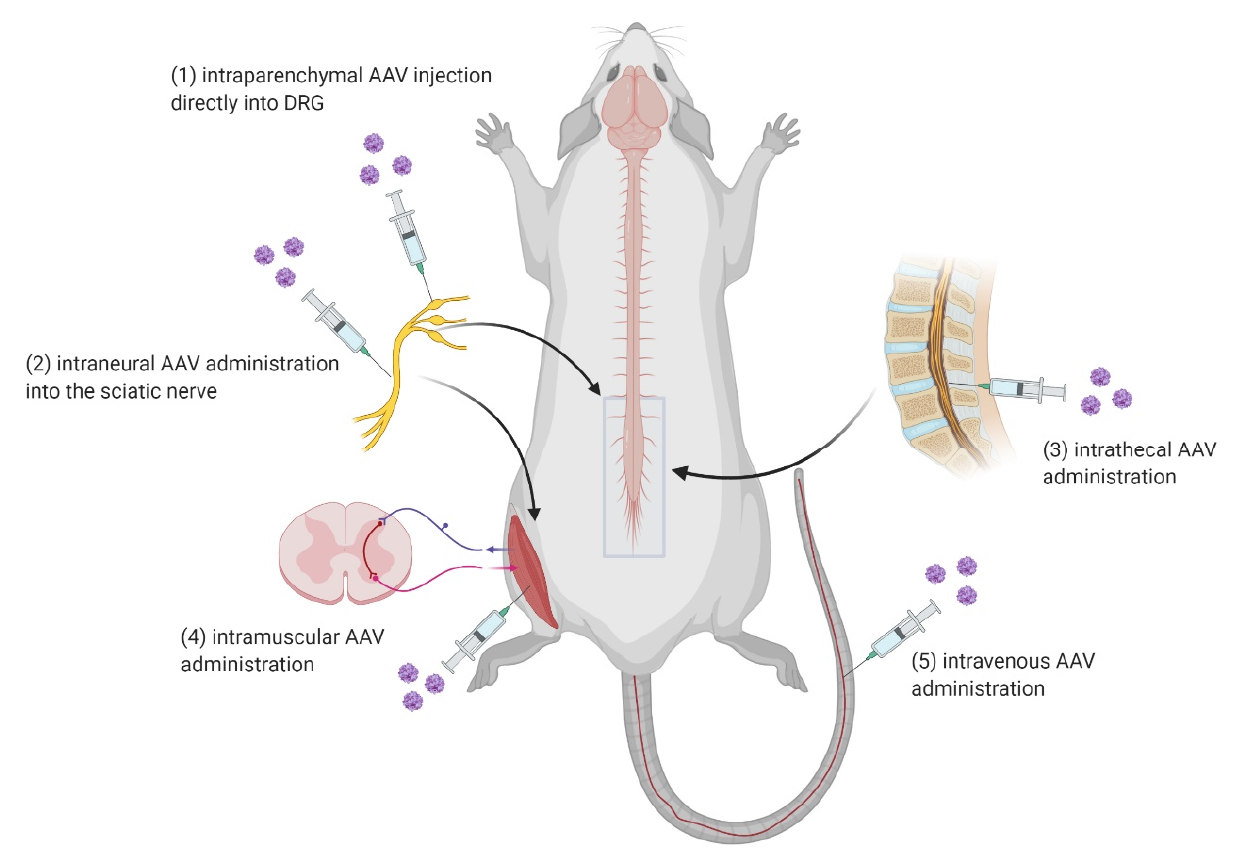
Figure 3. Possible routes of AAV vector administration into the spinal cord: ( 1 ) intraparenchymal, ( 2 ) intraneural, ( 3 ) in- trathecal, ( 4 ) intramuscular, and ( 5 ) intravenous AAV delivery (Created with